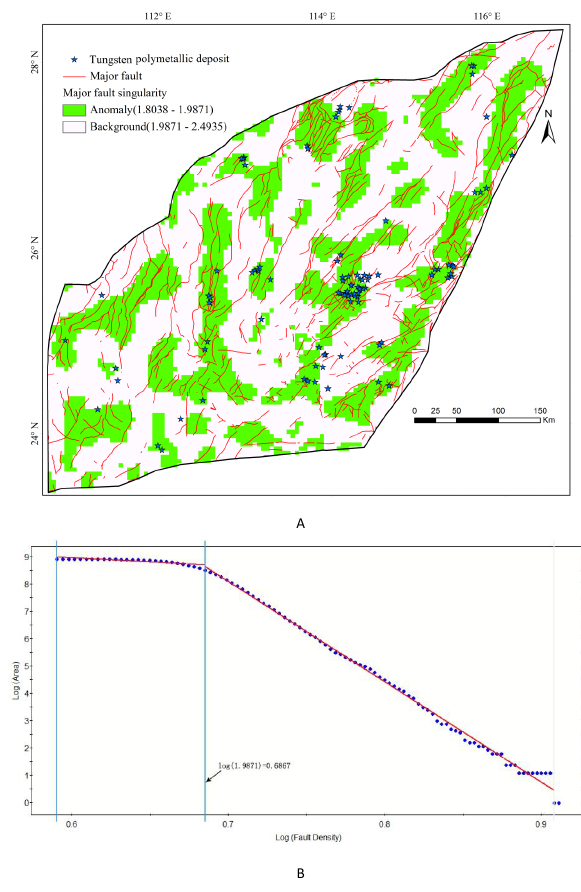
Fig.5. (A) Map showing major faults density singularity, and (B) Log–log plots for the secondary 437 faults. 438 Fig. 5. (A) Map showing major fault density singularity, and (B) Log-log plots for the secondary